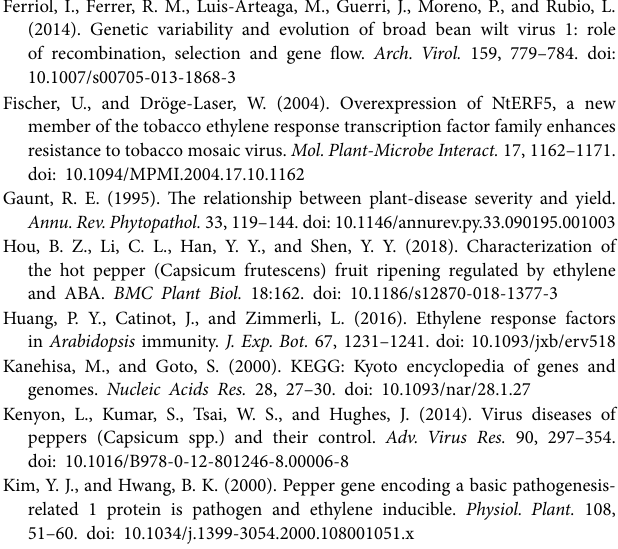
Supplementary Table S1 | Primers used in this study for quantitative real-time PCR.